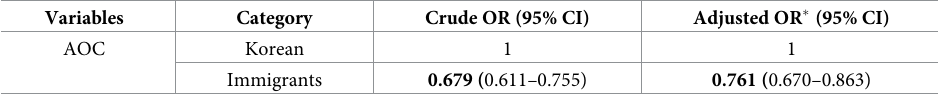
Table 3. Appropriateness of care (AOC) in depression management in immigrants compared to native